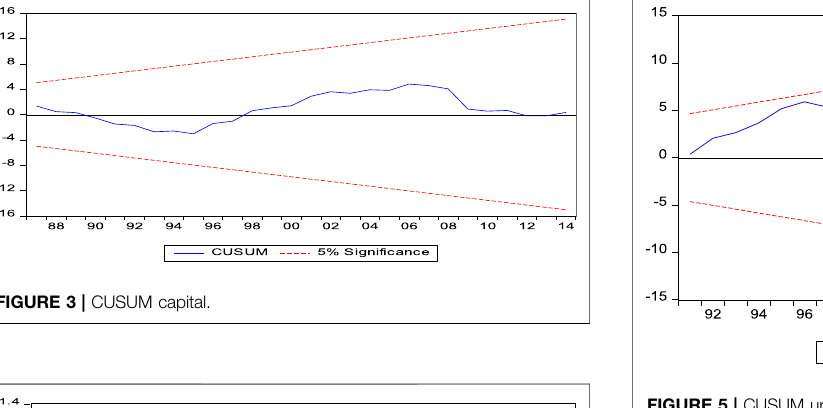
FIGURE 5 | CUSUM urbanization.